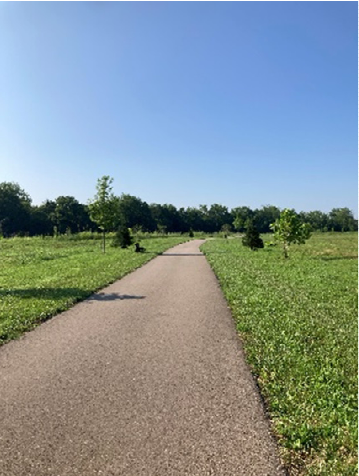
Figure 7. A paved walking path.